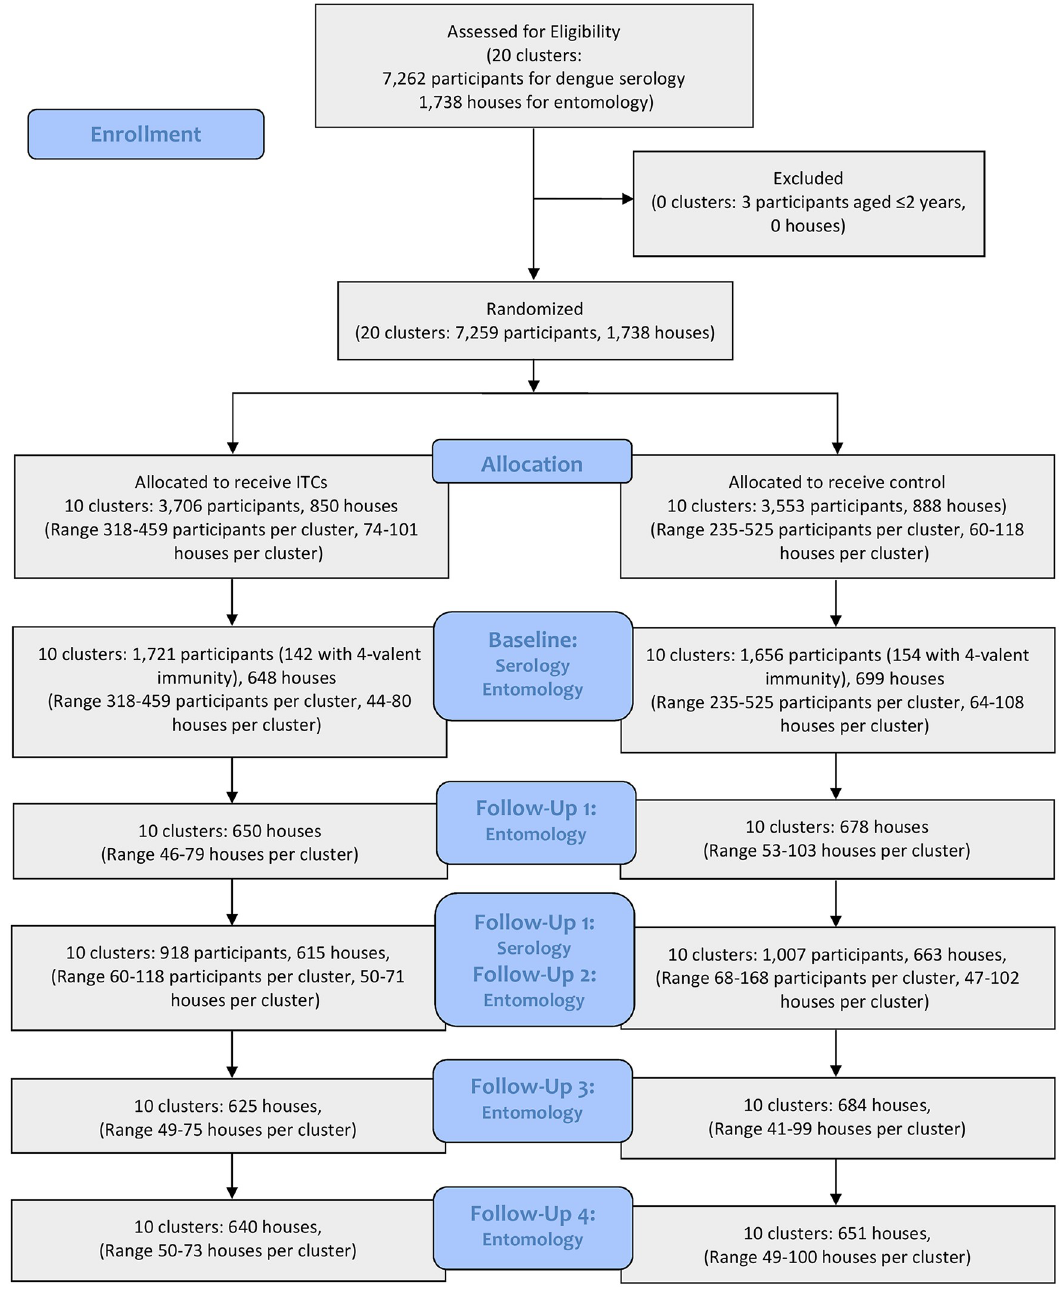
Fig 1. CONSORT flowchart describing the recruitment and retention of participants and allocation to each study